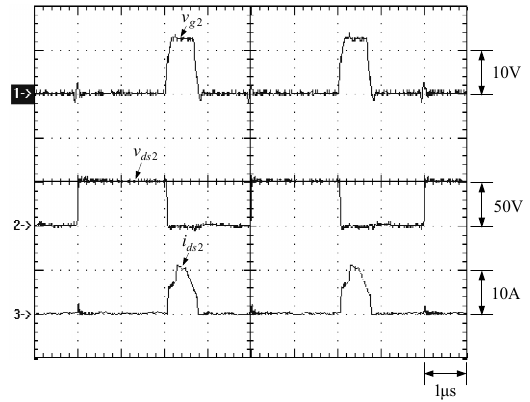
Figure 13. Waveforms relevant to S 1 : (1) v g 1 ; (2) v ds 1 ; (3) i ds 1 .